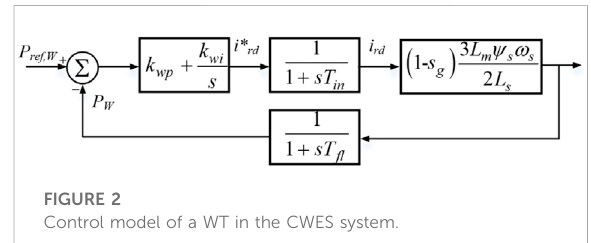
FIGURE 2 Control model of a WT in the CWES